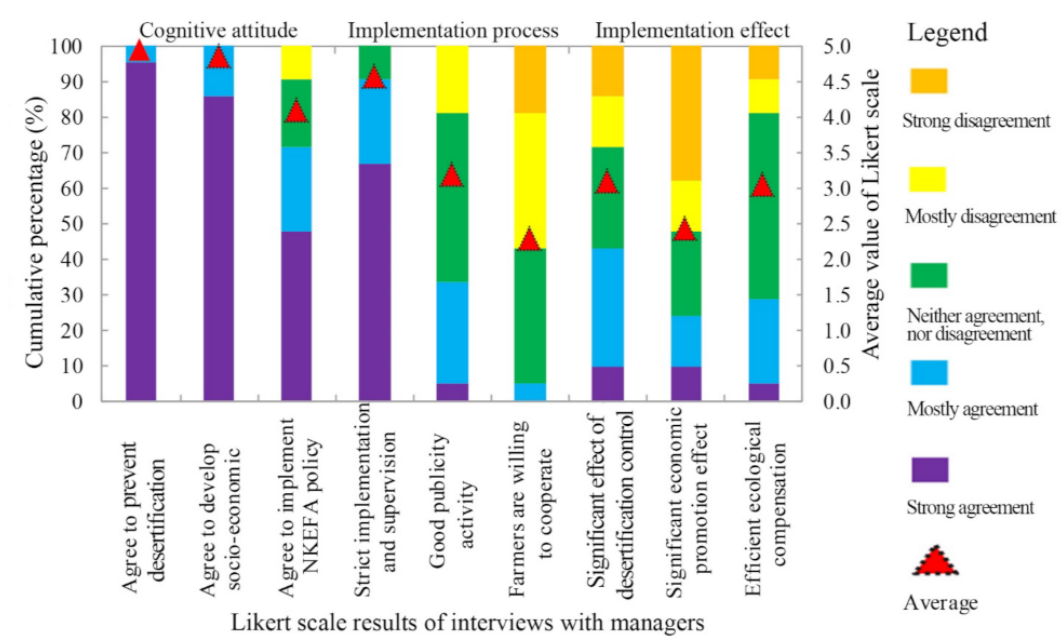
Figure 4. Results of interviews with managers. The symposium records were divided into 5 levels using Likert scale analysis (1 → 5: strong disagreement → strong